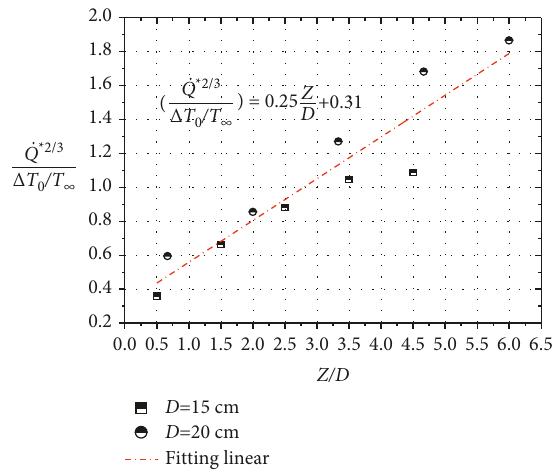
Figure 13: Dimensionless temperature profile of the fire plume as a function of normalized vertical height Z / D